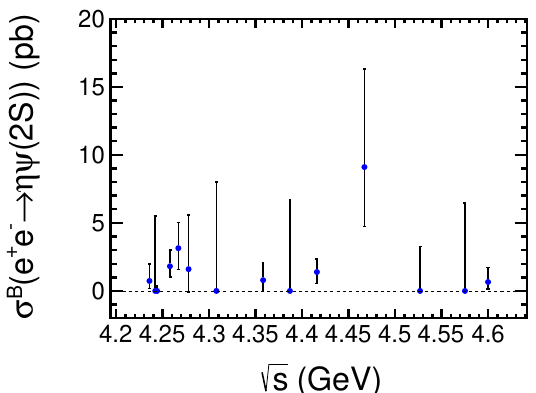
Figure 2. The measured Born cross section as a function of the collision energy. The uncertainties are statistical